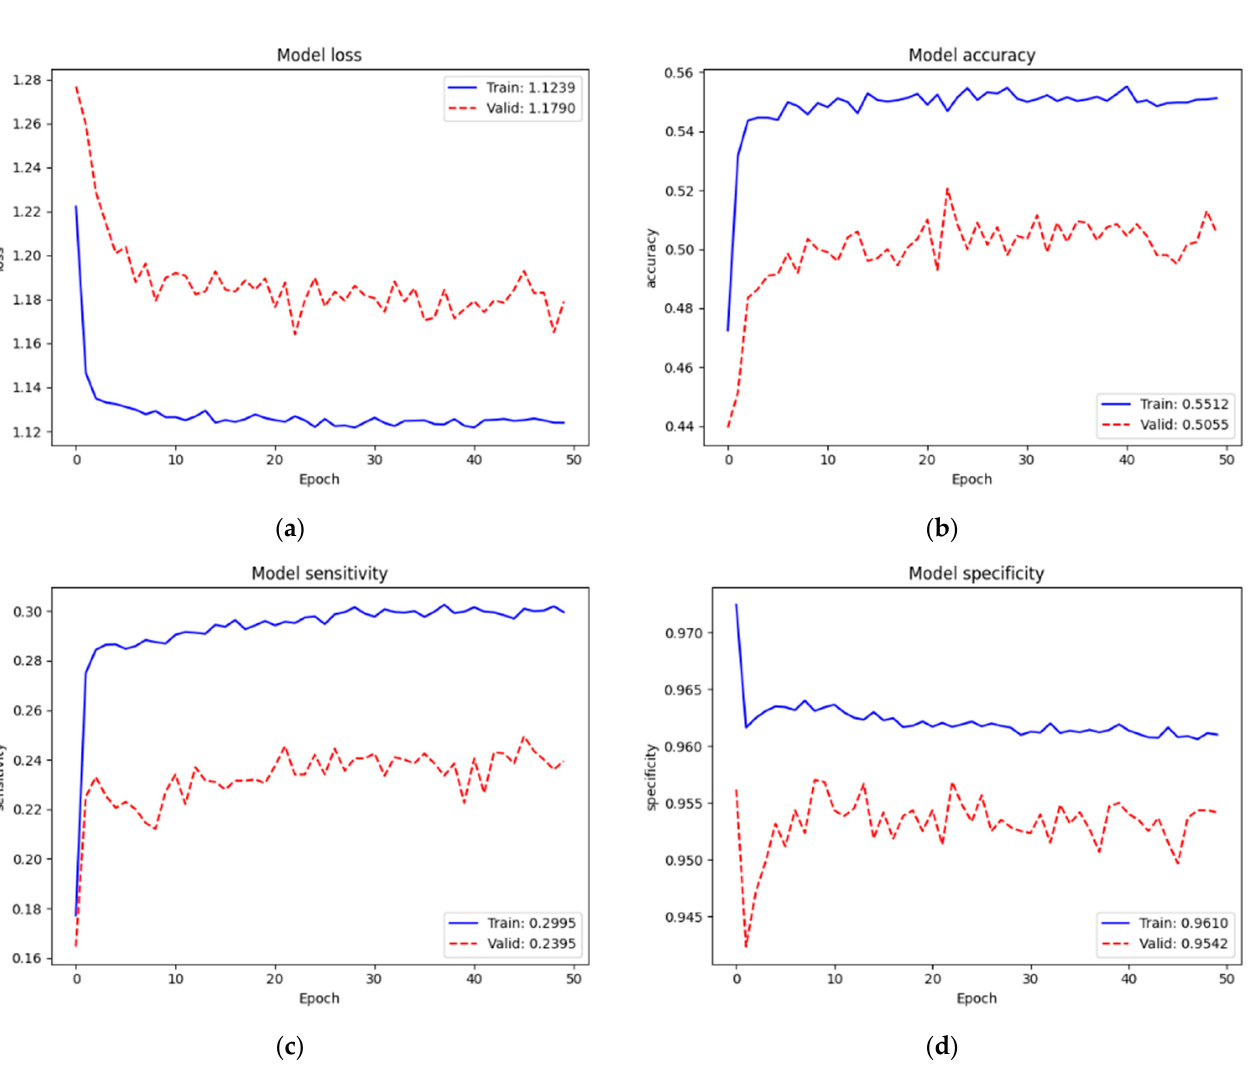
Figure 10. Training and validation performance of the SCH data set on new top layers: ( a ) loss; ( b ) accuracy; ( c ) sensitivity; ( d ) specificity.